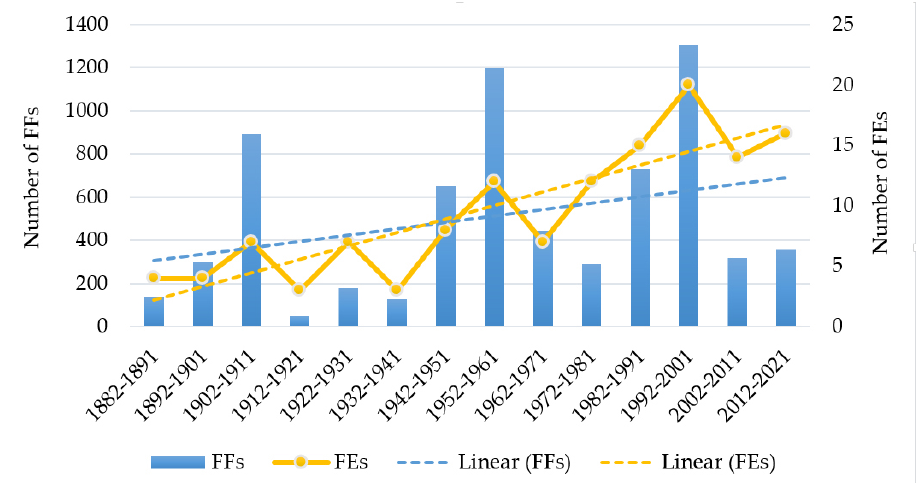
Figure 5. Number of events, FEs, and associated fatalities, FFs, per 10-year period